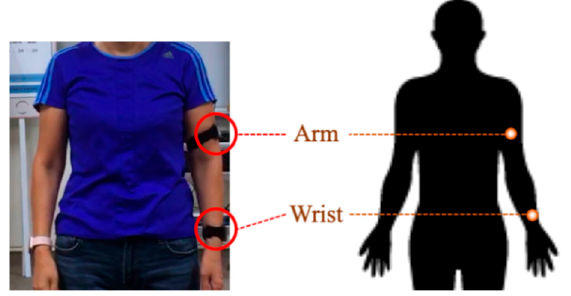
Figure 2. An illustration of the sensor placements.